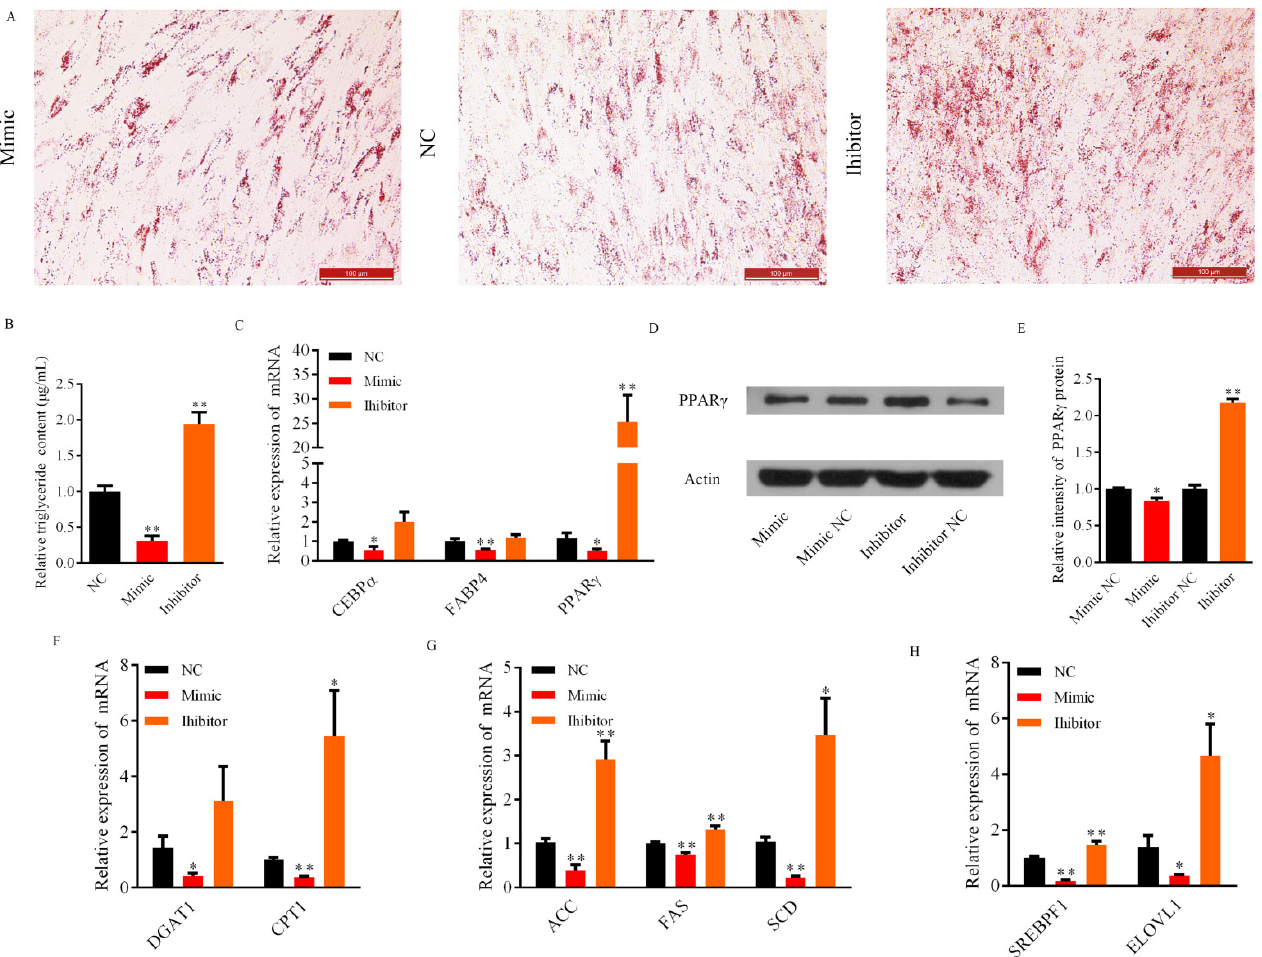
Figure 3. Bta-miR-2400 inhibits yak preadipocyte differentiation. Yak preadipocytes were transfected with bta-miR-2400 mimics, inhibitors or negative control (NC) for 10 days after induced differentiation. ( A ) Adipocytes were stained with Oil red O. ( B ) The cellular triglyceride content was analyzed by spectrophotometer. ( C ) Expression levels of adipogenic markers ( PPAR γ , FABP4 , and C/EBP α ). ( D , E ) The protein level of PPAR γ in adipocytes transfected with bta-miR-2400 mimics, inhibitors and negative control. The expression of genes related to ( F ) fatty acid transportation ( DGAT1 , CPT1 ), ( G ) fatty acid synthesis ( ACC , SCD and FAS ), and ( H ) lipogenic transcription ( ELVOL , SREBPF1 ). * p < 0.05; ** p < 0.01.